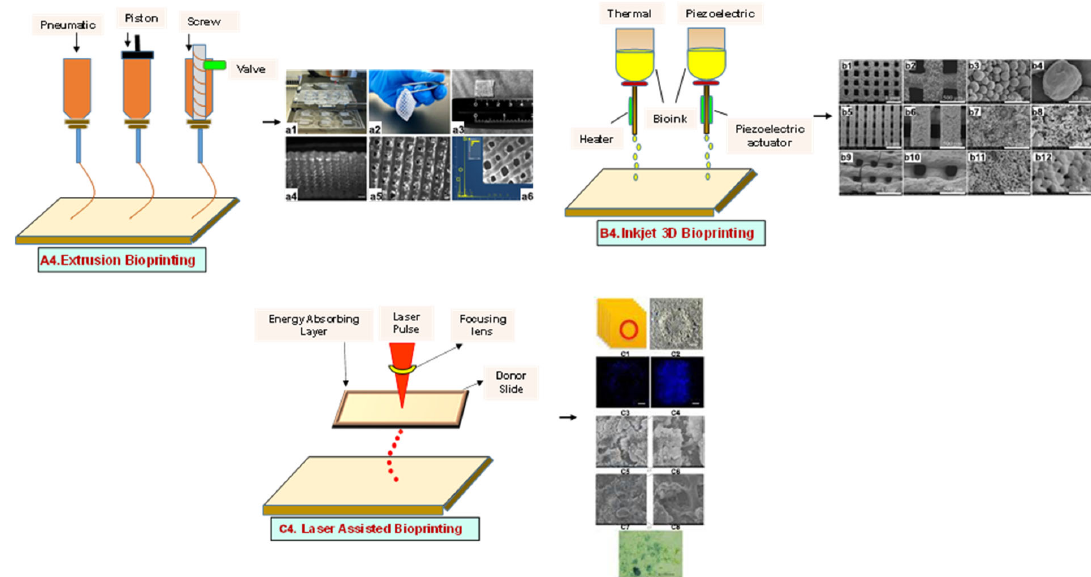
Figure 4. Schematic representation of different types of 3D printing methods and their microscopic images: ( A4 ) Extrusion method. ( a1 ) The 3D printing procedure, ( a2 , a3 ) Camera images showing 3D printed hydrogel construct. ( a4 , a5 ) High magnification images of the surface of the construct showing pores and struts morphology (scale bars at 1000 and 500 µ m, respectively). ( a6 ) The elemental compo- sition of the surface of the mesoporous silica-calcia nanoparticles containing hydrogel supported by a SEM image of the construct. Reprinted with permission from Ref. [107]. Copyright 2021, Elsevier Ltd. ( B4 ) inkjet 3D bioprinting. SEM microstructure displaying spherical powder sintered scaffolds ( b1 – b4 ), in addition to micropores on air jet milling powders sintered scaffolds surface ( b5 – b8 ), nano-sized grains sintered scaffolds showing many cracks ( b9 – b12 ). Reprinted with permission from Ref. [108], Copyright 2018, Elsevier Ltd. ( C4 ) laser-assisted bioprinting ( c1 ) Design of experiment, ( c2 ) Optical microscopy at day 0 (bar = 150 µ m). ( c3 ) Fluorescence microscopy showing cell migration and proliferation on day 3 (bar = 200 µ m). ( c4 ) Fluorescence microscopy showing a complete covering of the initial nHA pattern at day 6 (bar = 200 µ m). ( c5 , c6 ) Scanning electron microscopy of the nHA surface. HOP cells spread onto the material on day 3. ( c7 , c8 ) Scanning electron microscopy of the nHA surface. HOP cells spread onto the material on day 6. ( c9 ) ALP activity assay showing that HOPs maintain their osteoblastic phenotype at day 6. Reprinted with permission from Ref. [109] Copyright 2011, IOPscience (all adapted from